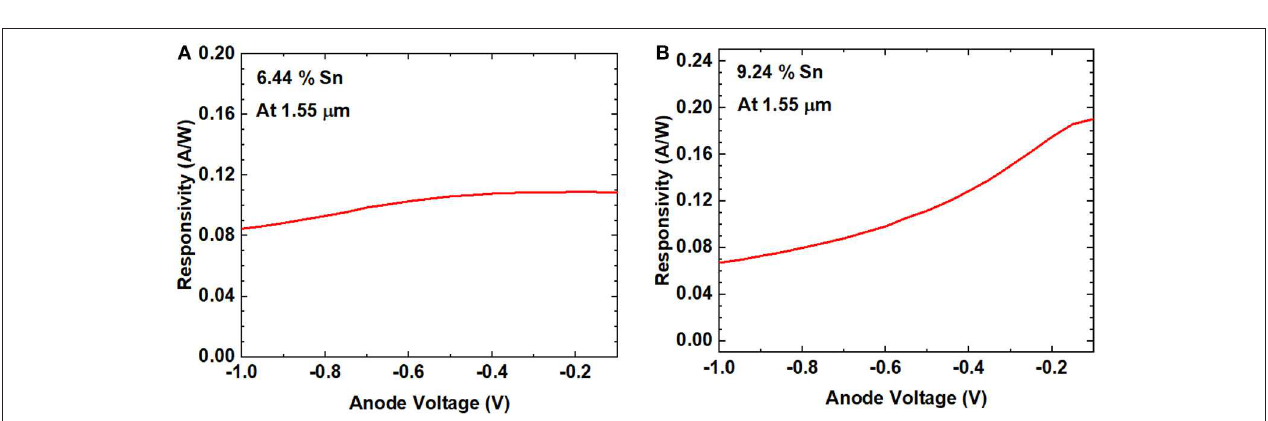
FIGURE 5 | Responsivity measured at 1.55 µ m of the (A) 6.44% Sn and (B) 9.24% Sn devices.